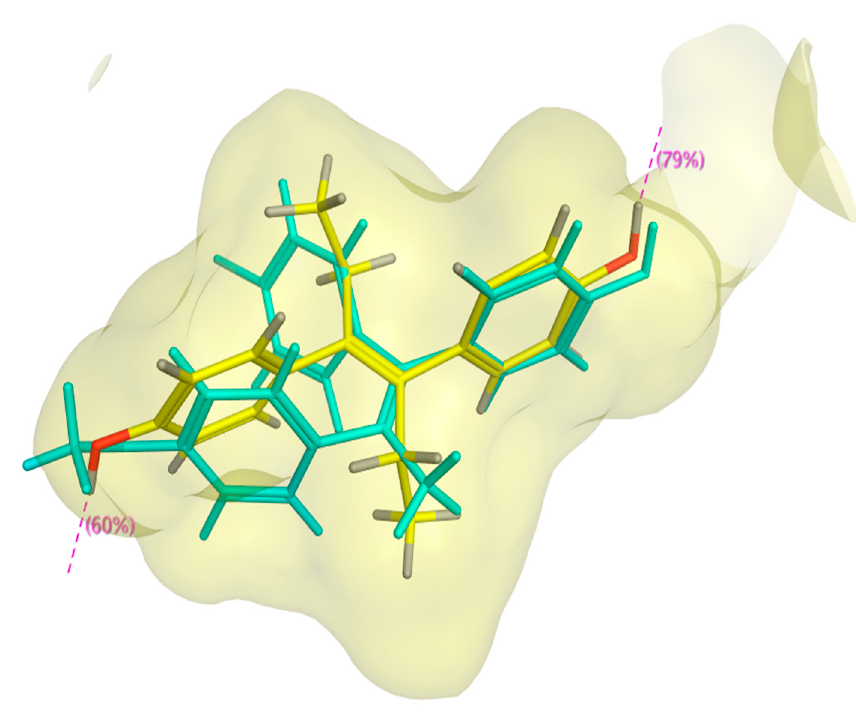
Figure 4. Compound 3 E ( cyan ) overlaid with DES ( yellow ) inside ER α LBD. Compound 3E retained the two essential interactions with Glu353 and His524, the oxygen of the methoxy group on ring A of compound 3E acted as H-bond acceptor rather than H-bond donor (Figure 5).